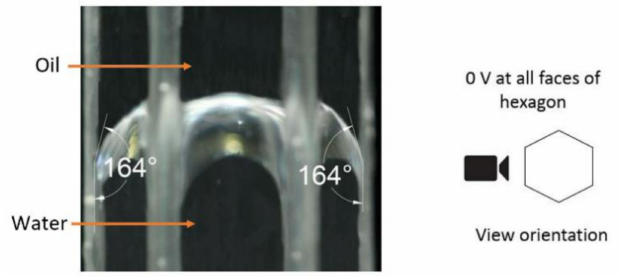
Figure 8. The hexagonal cell structure with an initial contact angle of 164 ◦ with 0 V on all six electrode